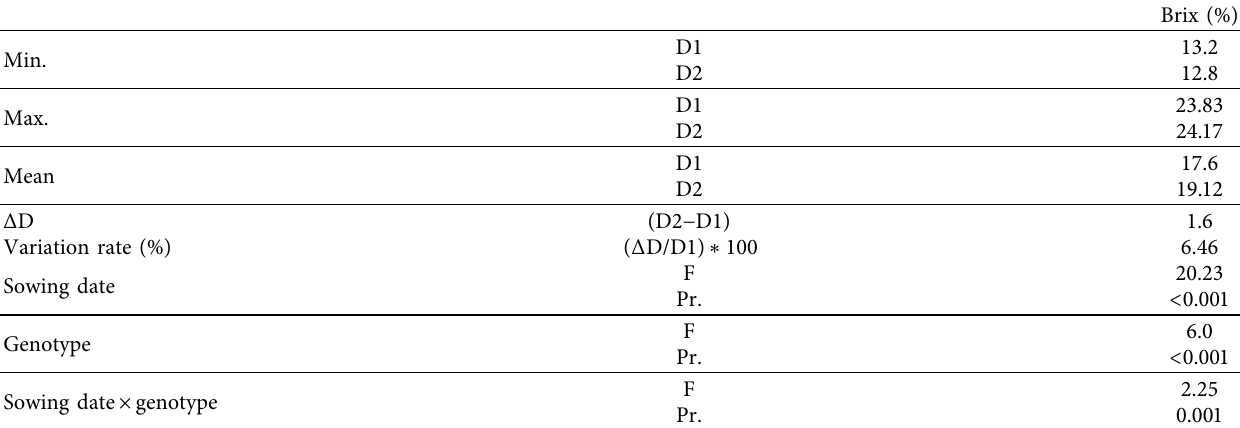
Table 4: Results of the analysis of variance of